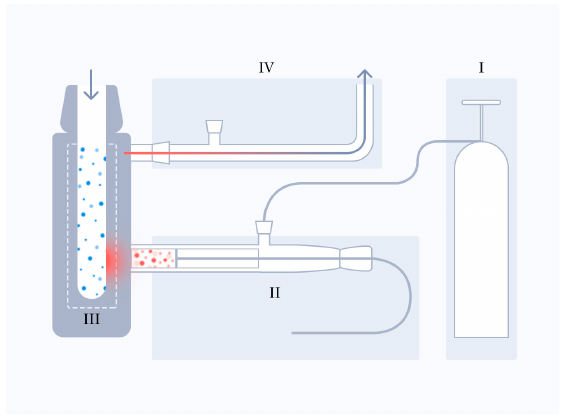
Figure 2. Nanostructure synthesis block-scheme.